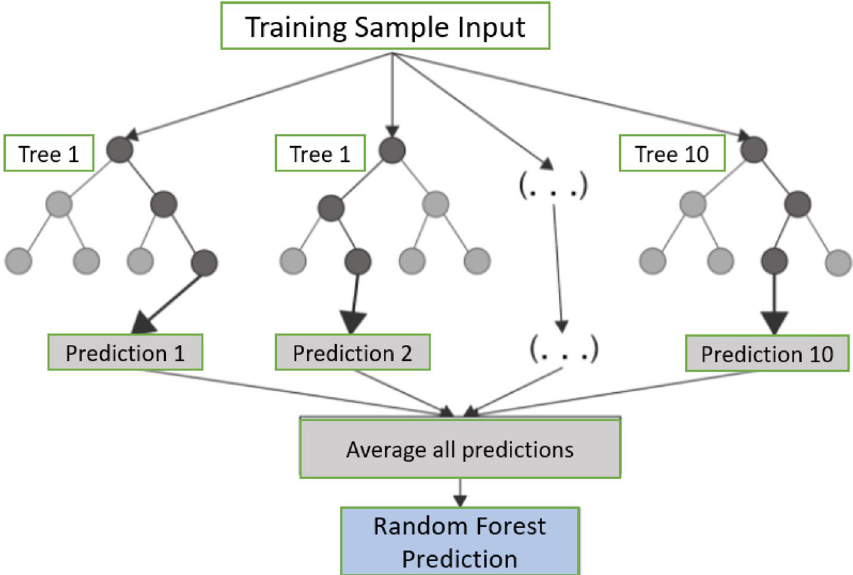
Fig. 13 Random forest archi-